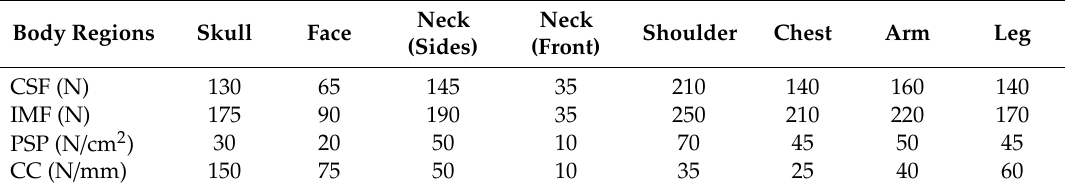
Table 3. Limit values for the forces, pressure, and body deformation constant according to the body